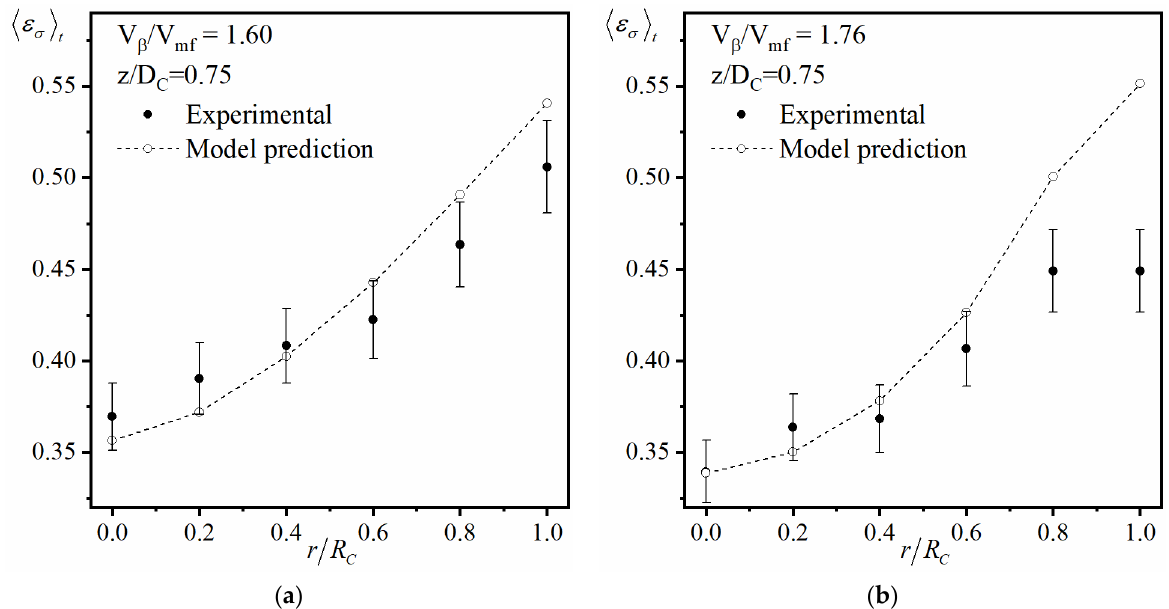
Figure 10. Radial holdup profiles for a fluidized bed of D C = 14 cm at an axial location of z / D C = 0.75 for (cid:11) (cid:10) V β / V mf = 1.60 and ( b ) ( a ) 0